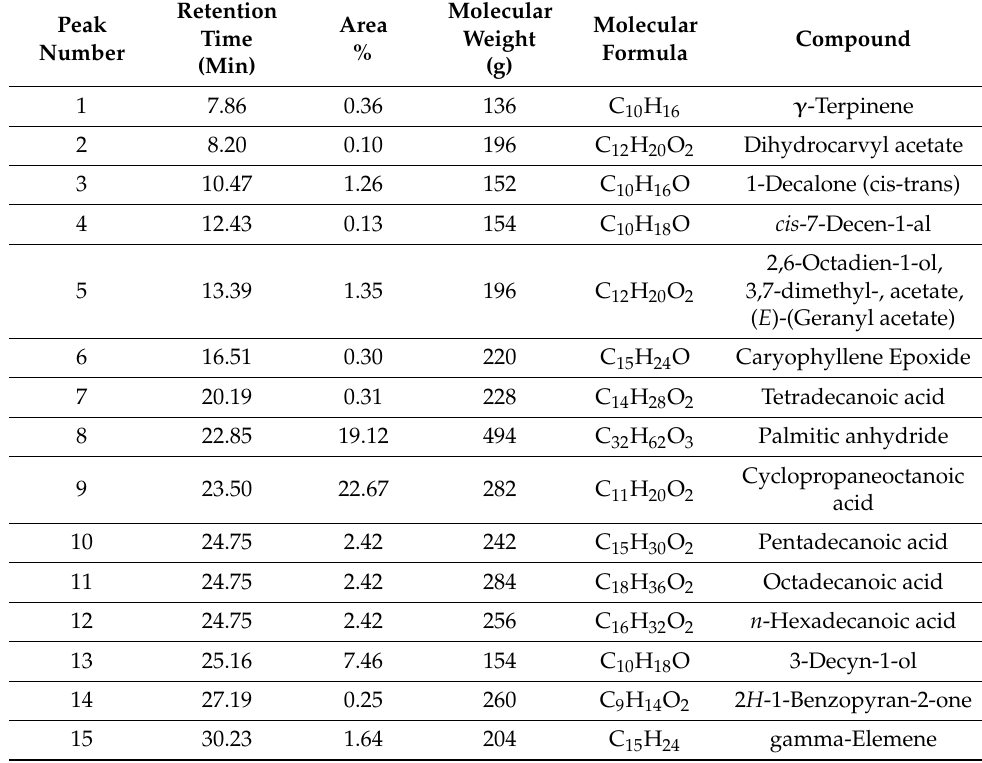
Table 1. Phyto-compounds identified in modified evaporated ethanol solvent extract of Woodfordia fruticosa